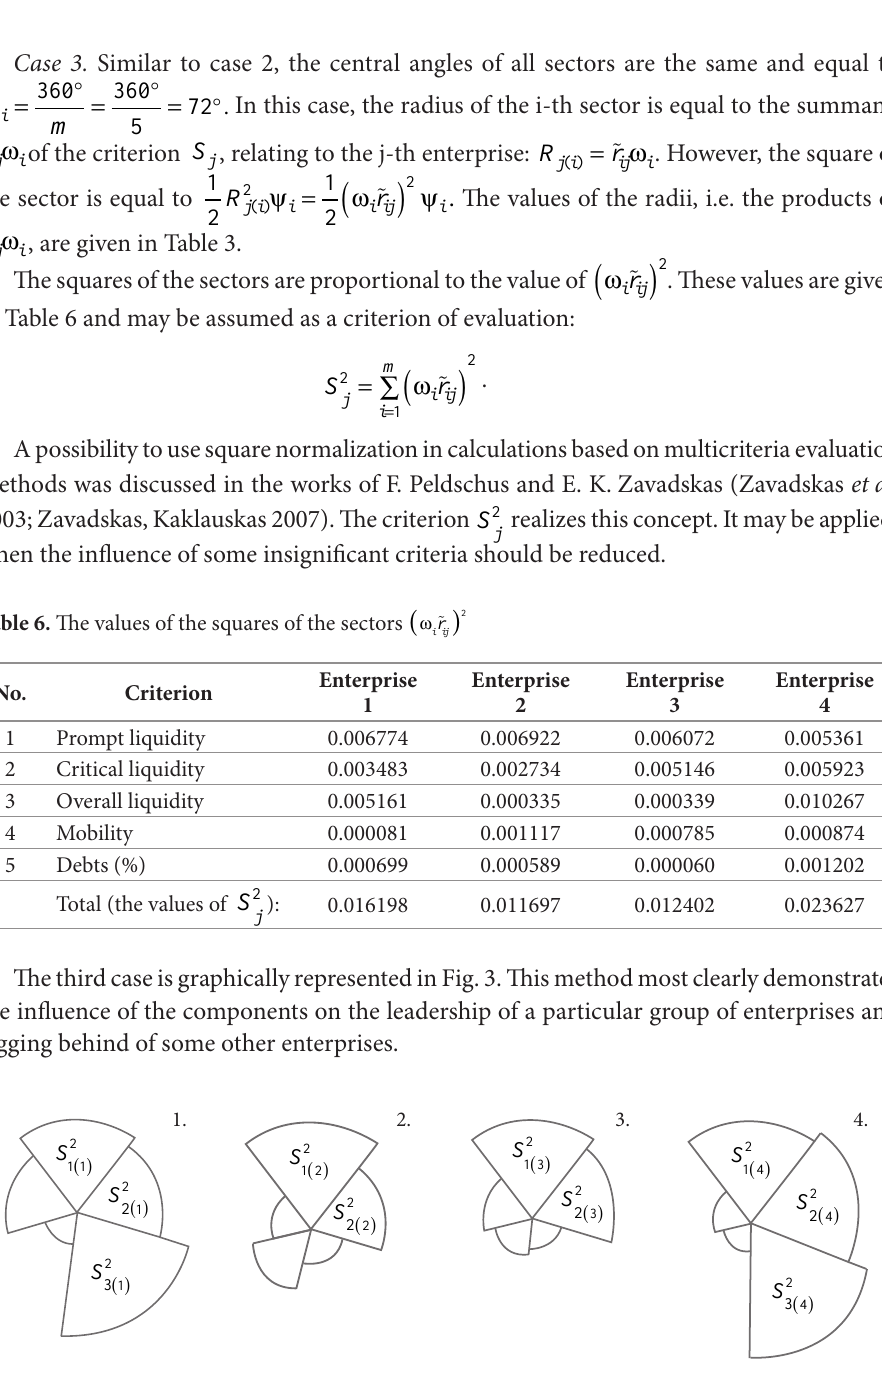
Fig. 3. A graphical view of case